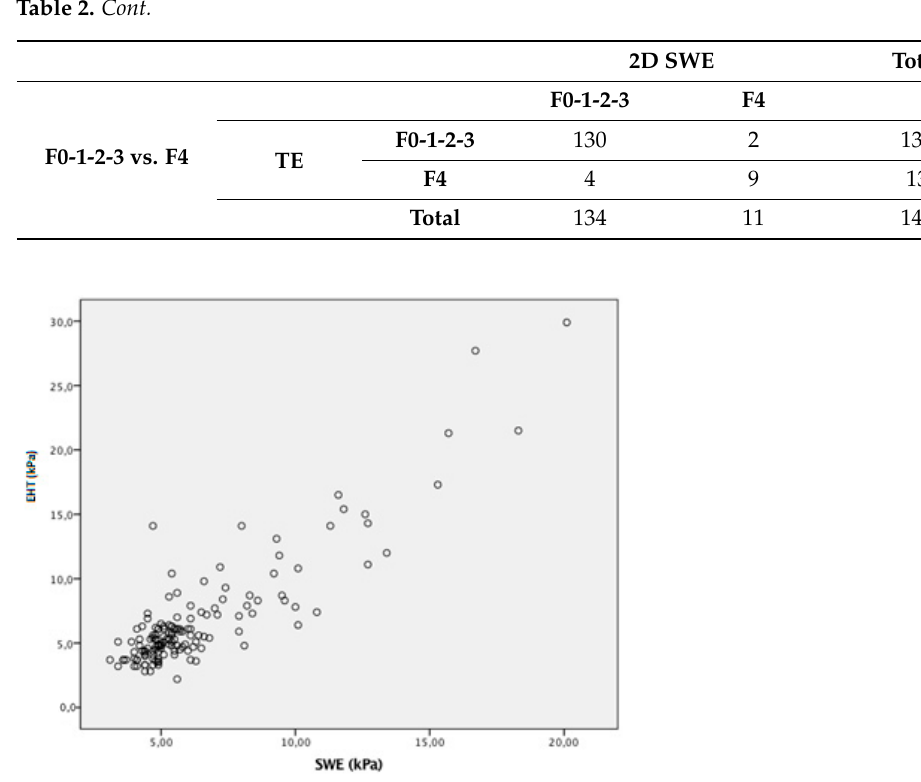
Table 4. Kappa coefficient index of agreement between TE and 2D-SWE in patients not in treatment and patients receiving antiviral therapy, and in patients without and with steatosis.